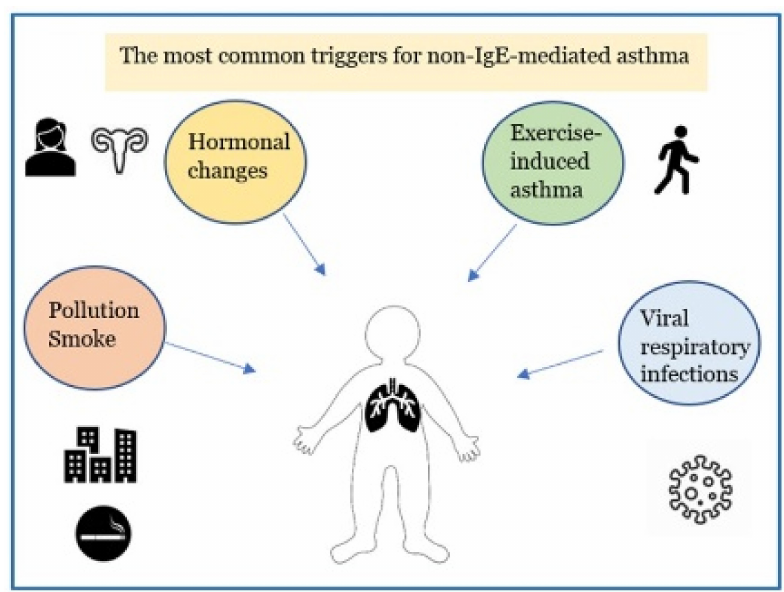
Figure 1. The major factors leading to non-allergic asthmatic exacerbations in